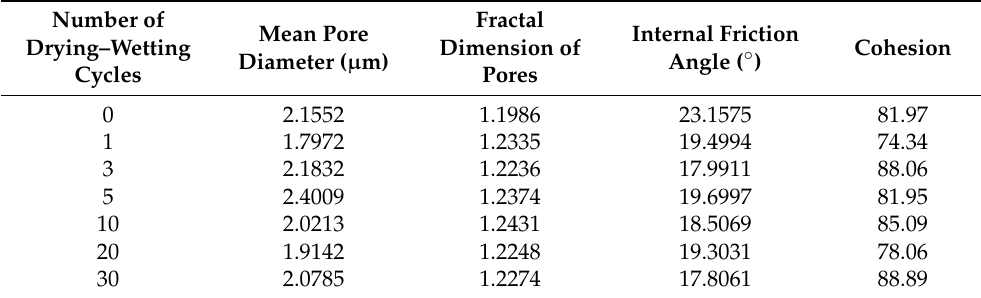
Table 9. Original data of microstructure and shear strength parameters under cyclic drying– wetting action.